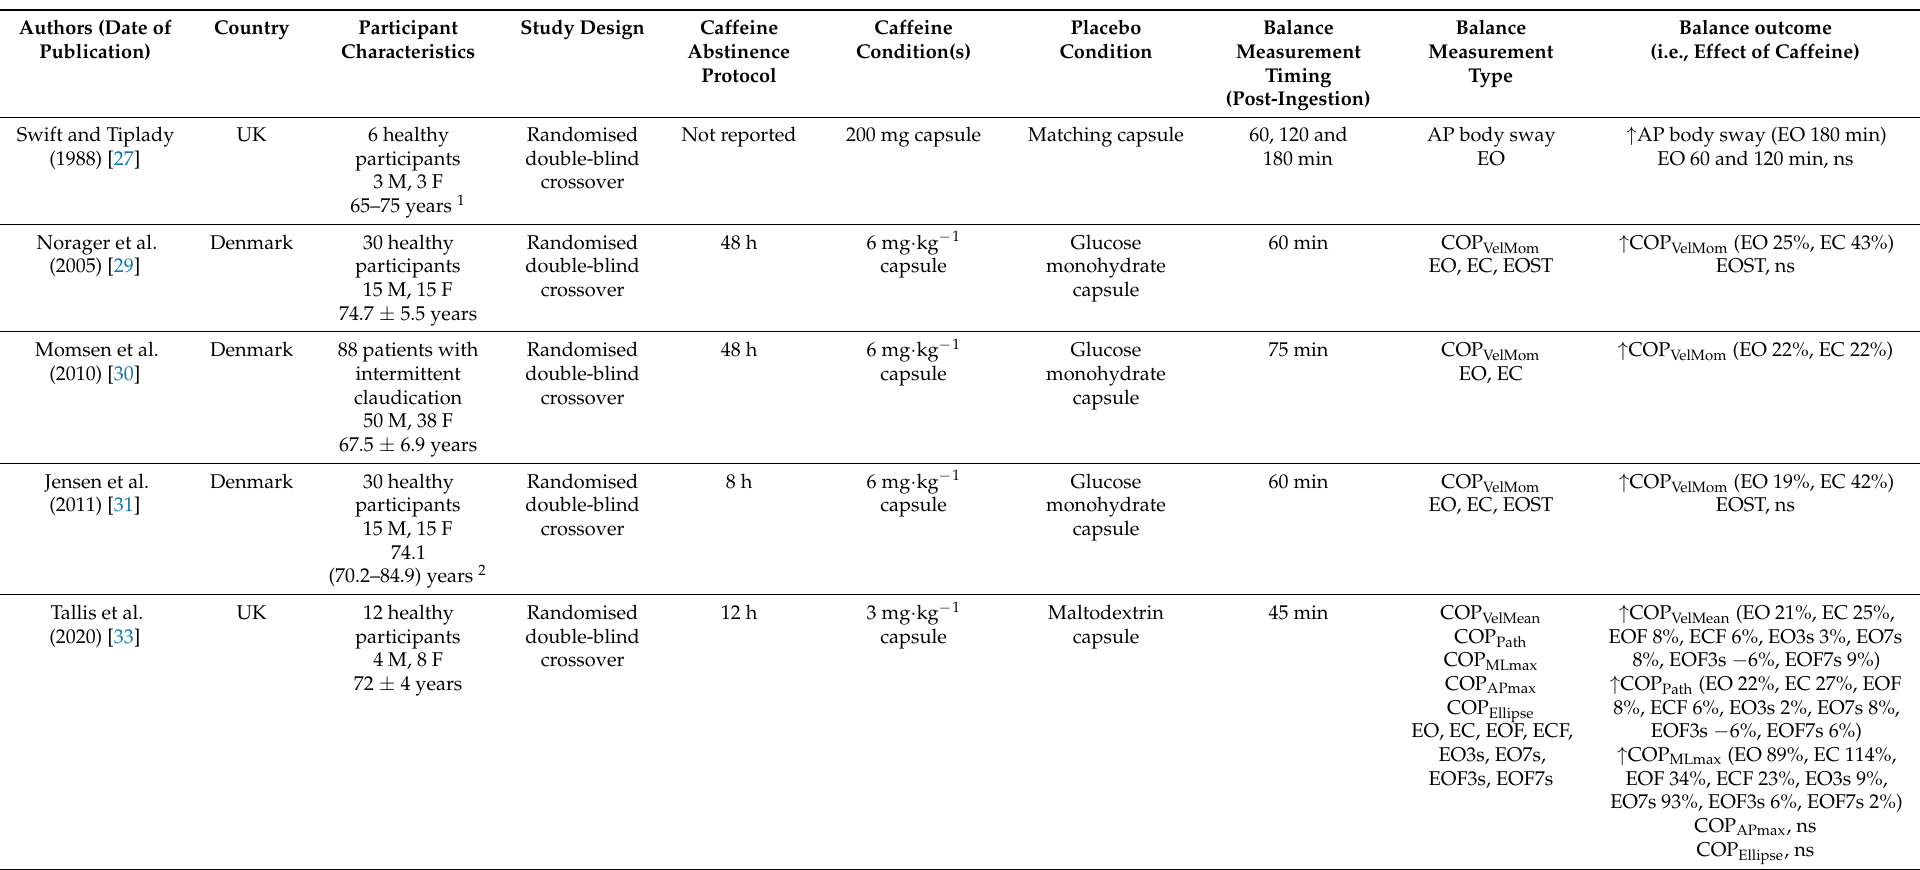
Table 5. Summary of the included studies with older